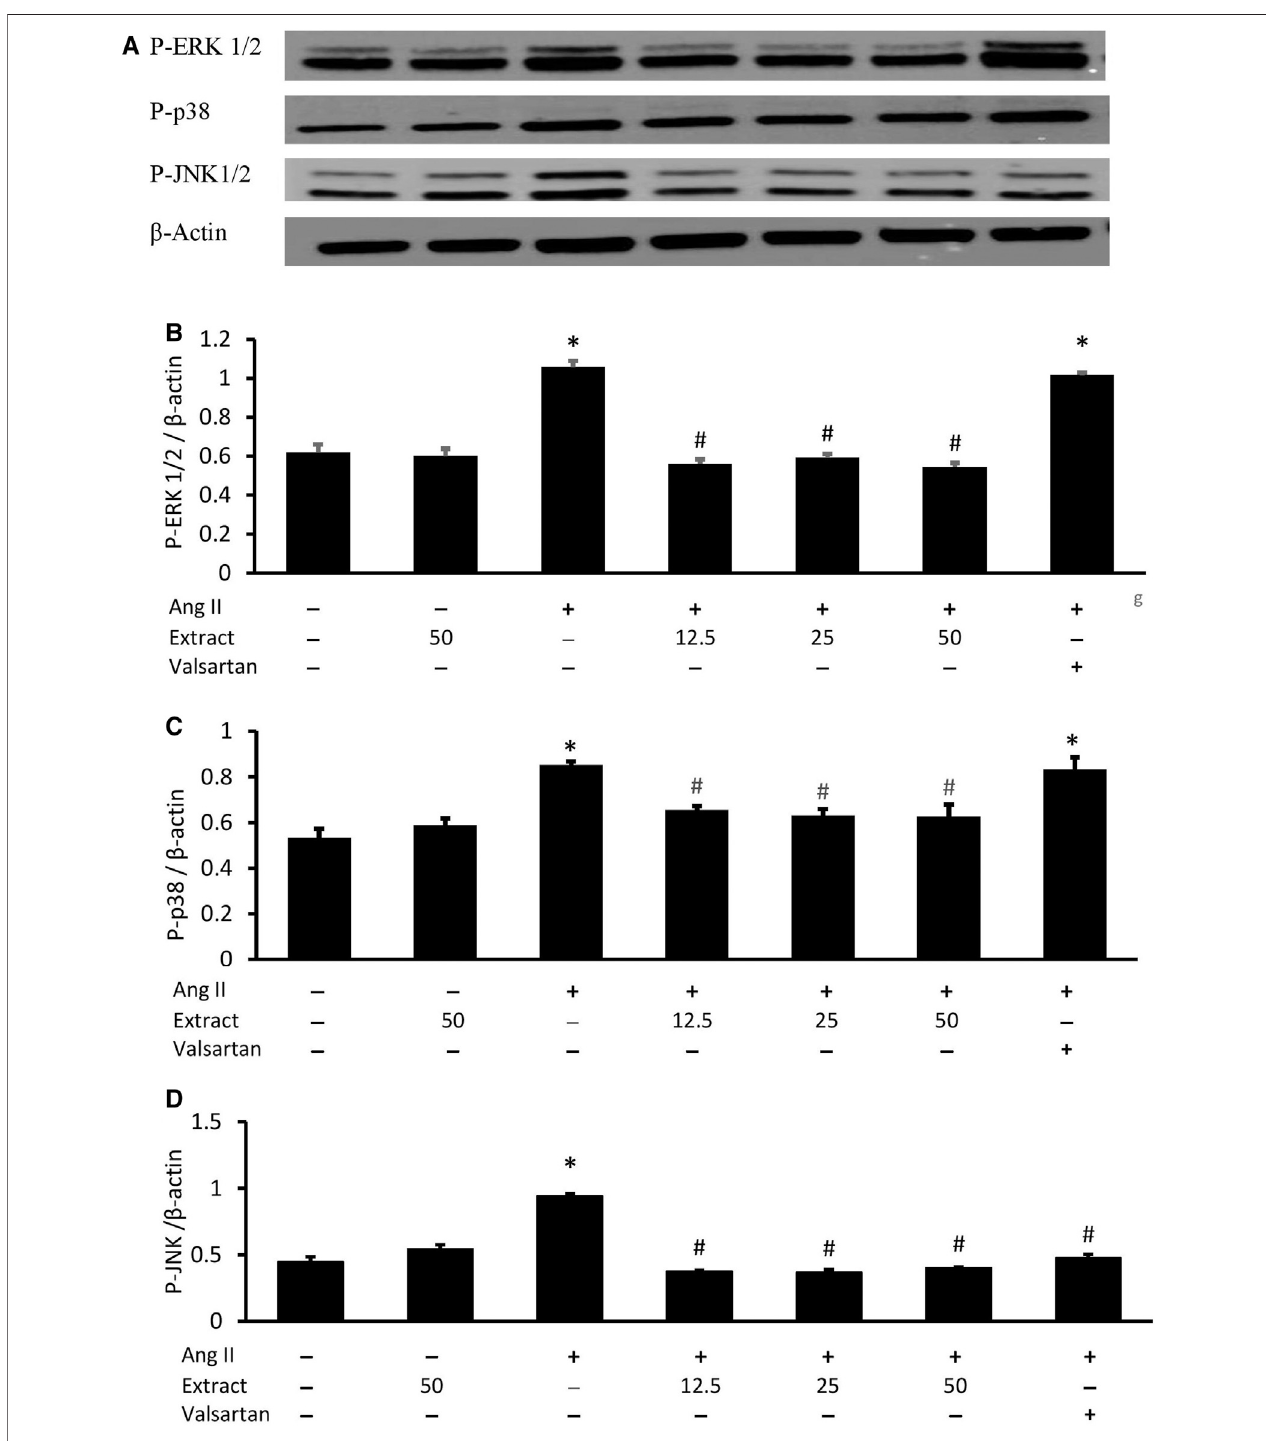
FIGURE 10 | Effects of Parkia speciosa empty pod extract and valsartan (20 μ M, positive control) on (A) representative immunoblots via Western blot analysis, quantitative analysis of phosphorylated (B) extracellular signal-related kinases (P-ERK1/2), (C) p38 kinase (P-p38), and (D) c-Jun N-terminal kinases (P-JNK) protein expressionsinH9c2cellsthatwereexposedtoAngII(600 nM)for24 h* p < 0.05vs.control(notreatment)group.# p < 0.05vs.AngIIcells.Barsrepresentmeans ± SEM ( n (cid:2) 3).